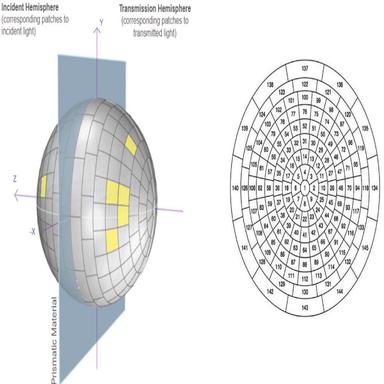
An incident angle schematic view of Klems BSDF (Left), Klems 145-patch hemispherical subdivisions (Right).